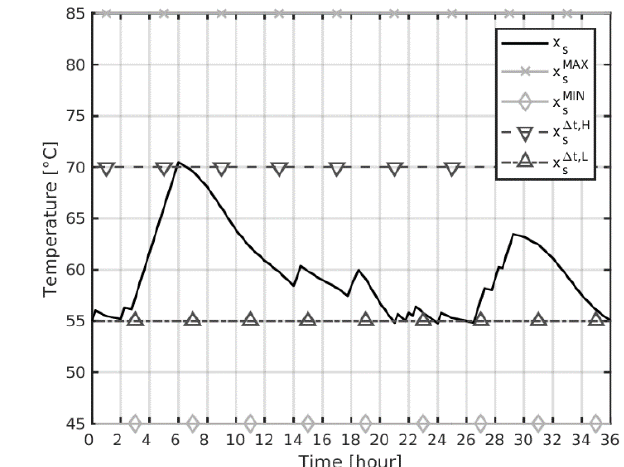
Figure 8. EWH temperature vs. planning period time, as per the optimised solution to the reference